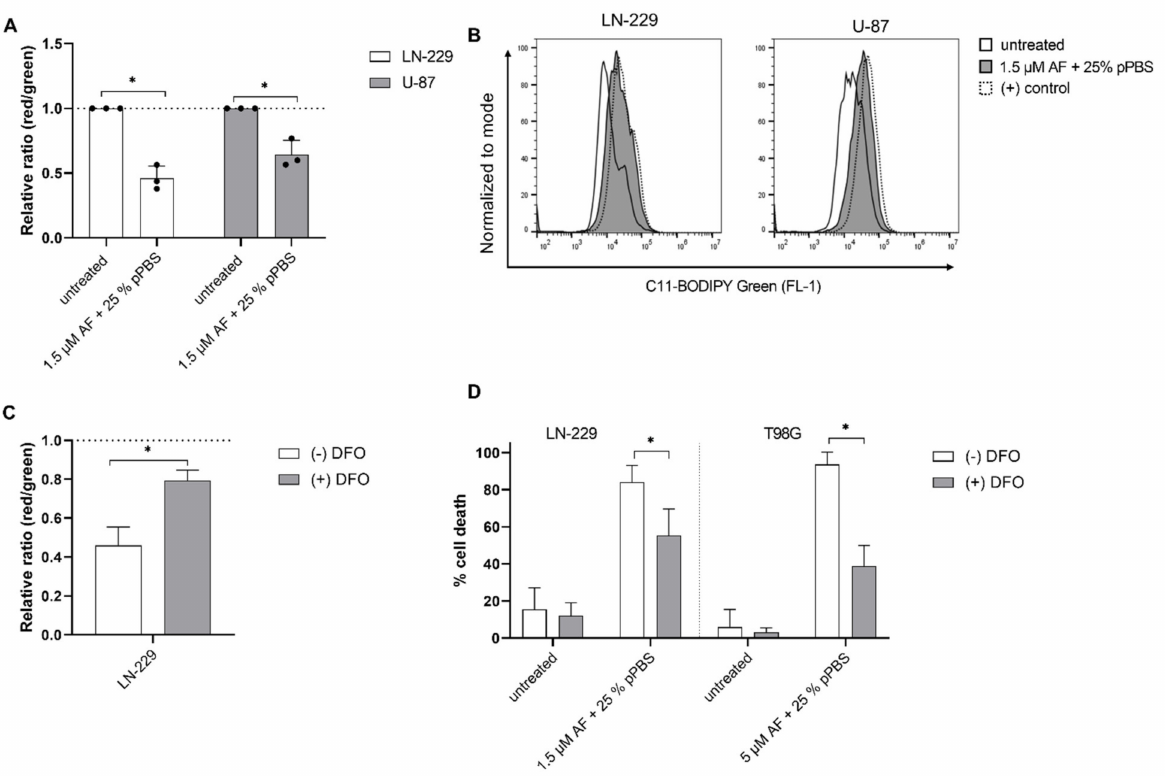
Figure 4. The combination treatment of AF and pPBS induces ferroptotic characteristics in GBM cell lines. ( A ) Lipid peroxidation presented as the relative ratio of red/green MFI signal after a flow cytometric analysis of the C11-BODIPY 581/591 reagent after 48 h of treatment of AF (1.5 µ M)) in combination with 25% pPBS. ( B ) Representative overlay histograms of C11 BODIPY green signal (FL-1) after combination treatment of 1.5 µ M AF with 25% pPBS for 48 h or cumene hydroperoxide (positive control) for 2 h. ( C ) Lipid peroxidation presented as the relative ratio of red/green MFI signal of the C11-BODIPY 581/591 reagent in absence or in presence of DFO (100 µ M) after 48 h of combination therapy with 1.5 µ M AF and 25% pPBS in LN-229 cells. ( D ) Percentage of cell death after 48 h of treatment of AF (1.5 µ M or 5 µ M) in combination with 25% pPBS in the absence and presence of DFO (100 µ M), an inhibitor of ferroptosis. Graphs represent mean ± SD of ≥ 3 independent experiments. * p ≤ 0.05 denotes a statistically significant difference compared with untreated